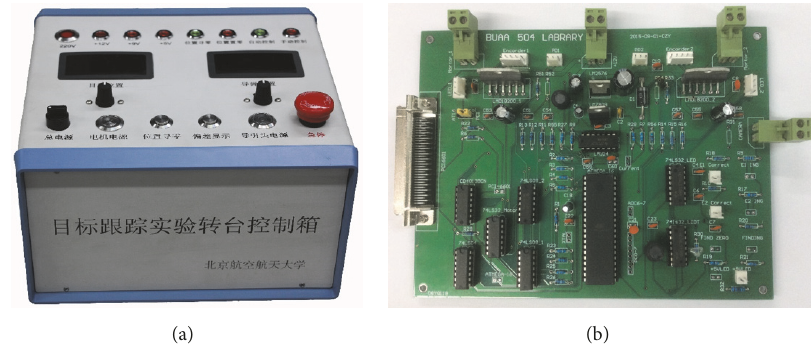
Figure 3: (a) is the control cabin, and (b) is the